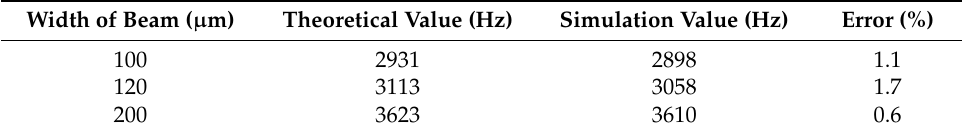
Table 3. The effects of the width of the beam on the resonant frequency.